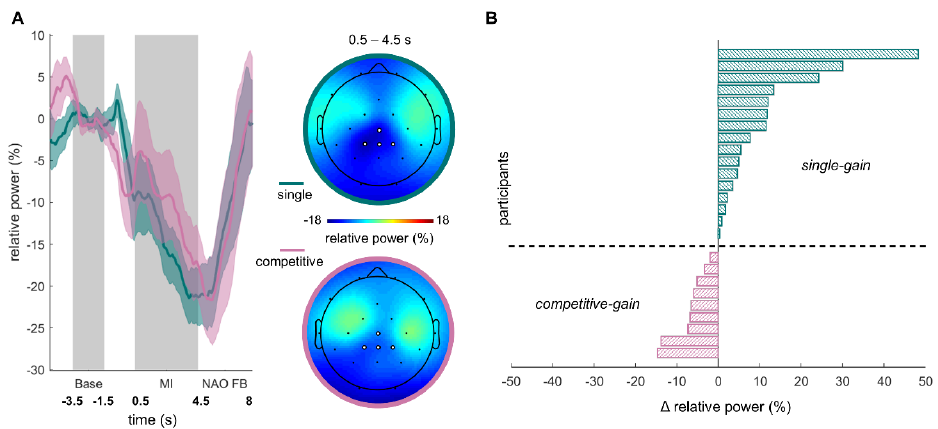
Figure 2. Comparison of relative ERD in single and competitive multi-user conditions.